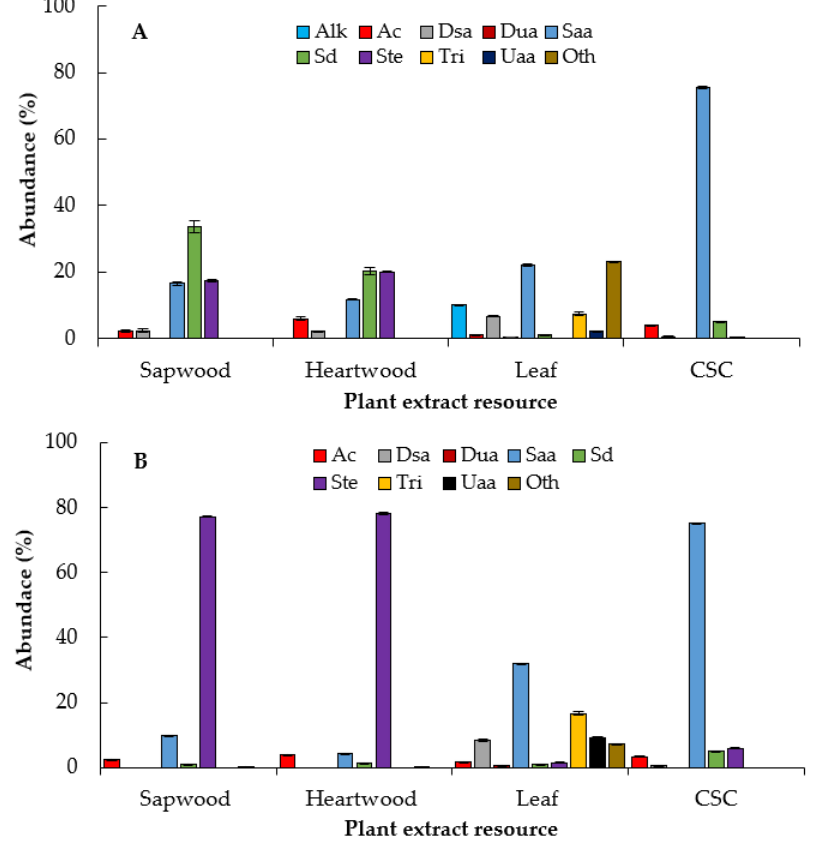
Figure 4. Chemical groups summarized by plant extracts resource of E. platycarpa . ( A ) Fatty hexane extract; ( B ) defatted hexane extract. Alk: alkanes; Ac: aromatic compounds; Dsa: derivatives from saturated alkanoic acids; Dua: derivatives from unsaturated alkanoic acids; Saa: saturated alkanoic acids; Sd: saturated diacids; Ste: steroids; Tri: triterpenoids; Uaa: unsaturated alkanoic acids; Oth: others. CSC: Cell suspension cultures. Values represent the mean ± standard deviation of two replicates.